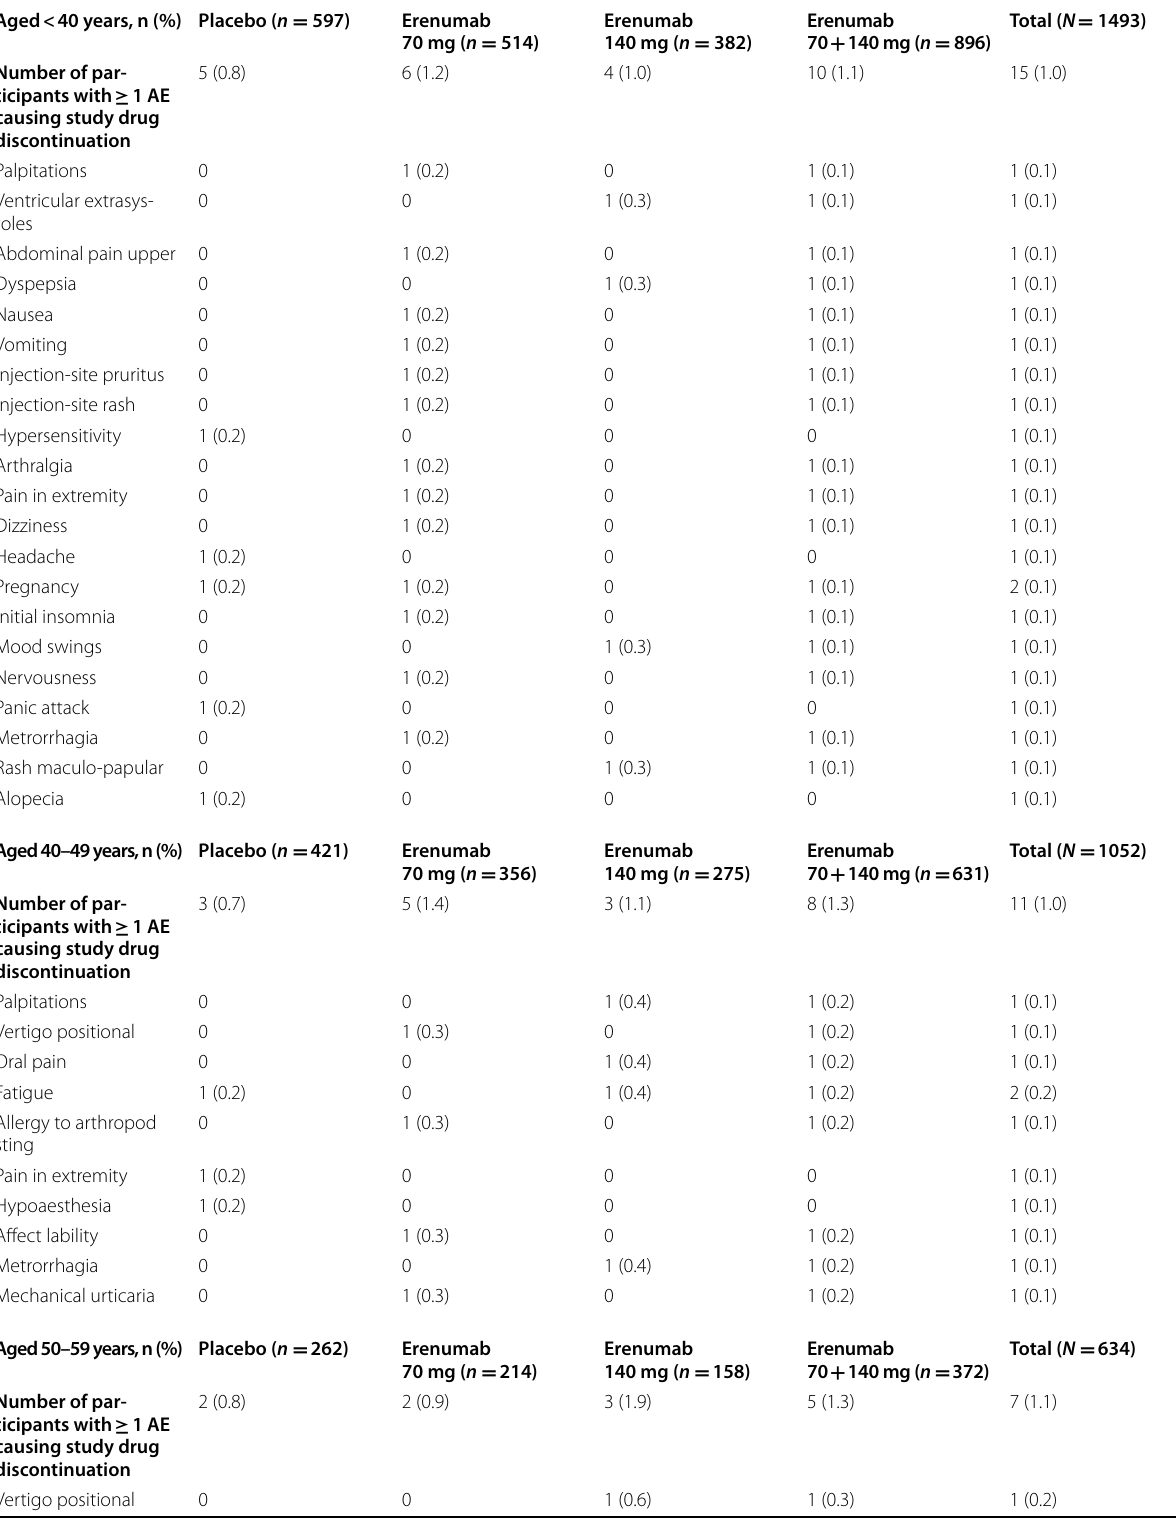
Table 5 TEAEs causing study drug discontinuation across age groups, by preferred term (safety analysis set) Aged < 40 years, n (%) Placebo ( n =